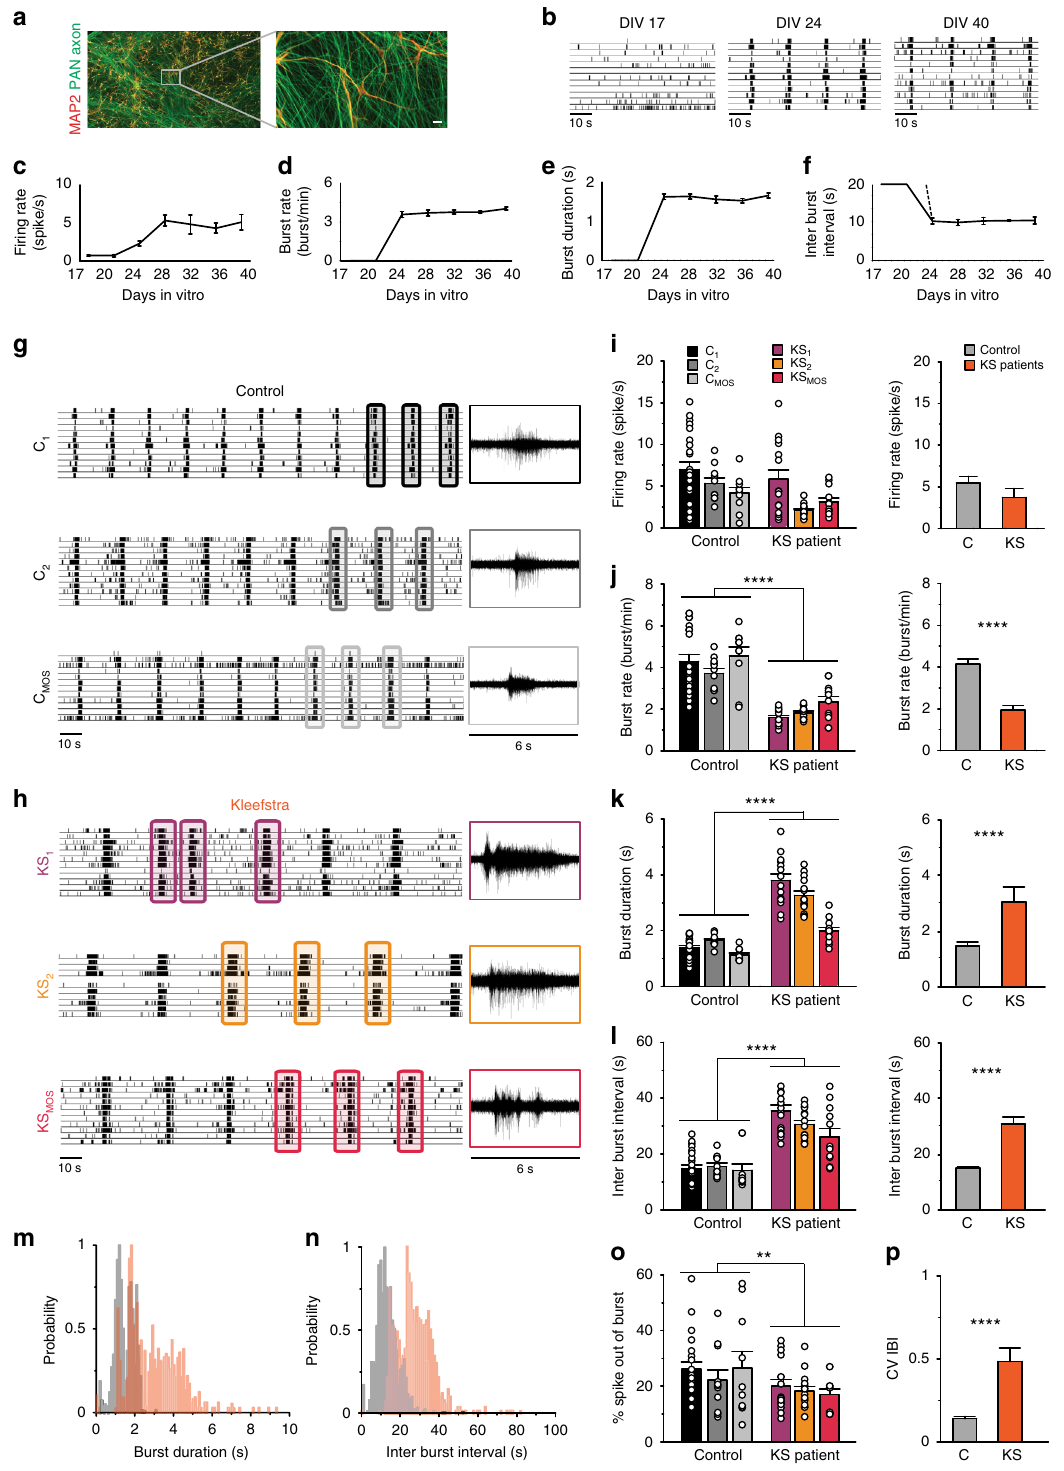
Fig. 2 Spontaneous electrophysiological activity of control- and KS patient-derived neuronal networks. a Representative image of a control-derived neuronal network on MEAs stained for MAP2 (red) and PAN Axon (green). b Representative raster plot of electrophysiological activity exhibited by control-derived neuronal network at different time points during development. c – f Quanti fi cation of network properties as indicated. g , h Raster plot of spontaneous electrophysiological activity exhibited by g control and h KS networks at DIV 28. 6s of raw data showing a burst recorded from a representative channel are shown for each iPS line. i – l Quanti fi cation of network parameters as indicated. m , n Histogram showing the distribution of m the network burst duration (bin size = 100ms) and n the network inter burst interval (bin size = 1s). o Quanti fi cation of percentage of spike outside network burst and p quanti fi cation of coef fi cient of variability of the inter-burst interval. n = 23 for C 1 ; n = 10 for C 2 ; n = 10 for C MOS ; n = 15 for KS 1 ; n = 15 for KS 2 ; n = 12 for KS MOS . Data represent means±SEM. * P <0.05, ** P <0.005, **** P <0.0001, one-way ANOVA test and post hoc Bonferroni correction was performed between controls and KS patient- derived cultures and Mann – Whitney test was performed between two groups. Source data is available as a Source Data fi